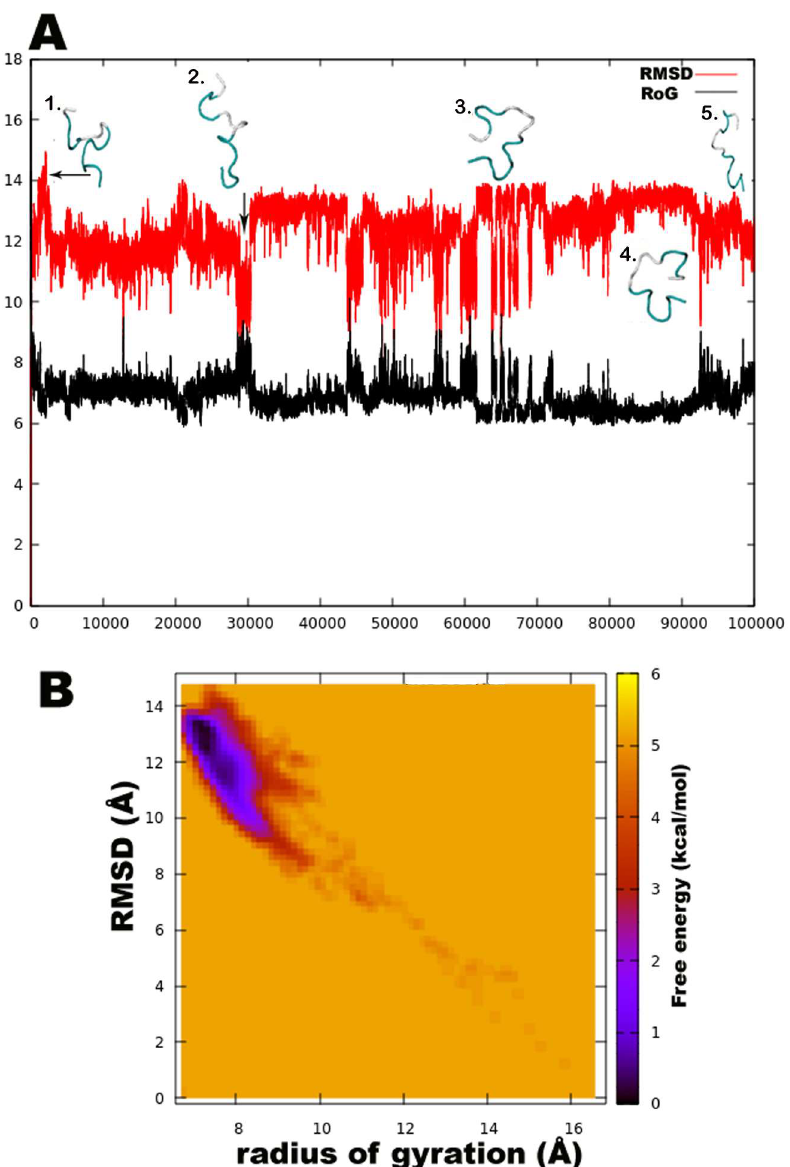
Figure 2. ( A ). The root-mean-square-deviation (RMSD in red color) and radius of gyration (RoG in black) with corresponding three-dimensional structures of trikoningin KA V, ( B ). Free energy landscape as a function of RMSD and RoG shows energetically favoured conformations with RMSD between 12–14 Å and RoG value less than 8 Å. Table 3. Backbone H-bonds of Trikoningin KA V along with their frequency of occurrence given by fraction, average distance, and angle.